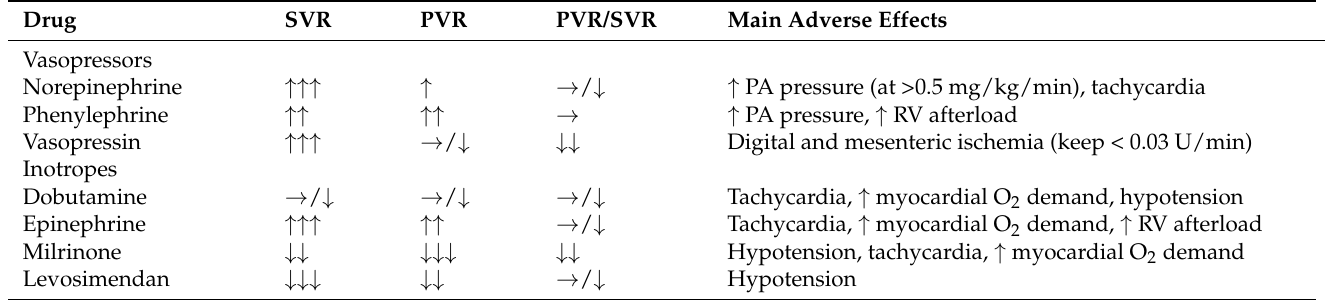
Figure 3. Specific management of RV failure. The figure illustrates the five critical components of the treatment of RV failure, including: ( 1 ) The increase of arterial blood pressure (BP) using vasopressors, including norepinephrine (NE, first line) and vasopressin (second line, when NE doses are >0.5 µ g/kg/min). ( 2 ) The maintenance of sinus rhythm, using anti-arrhythmic drugs or direct current cardioversion in case of atrial fibrillation. ( 3 ) The optimization of RV preload, monitored by echocardiography and central venous pressure. The aim is to ensure adequate RV filling (target a CVP of 8–12 mm Hg) and to aggressively treat volume overload, as evidenced by dilated RV and paradoxical septum movement towards the left ventricle (LV) cavity, using diuretics or renal replacement therapy (RRT). ( 4 ) The reduction of RV afterload (a) by avoiding elevated plateau pressure (P Plat ), driving pressure (DP), and positive end-expiratory pressure (PEEP) in mechanically ventilated patients; (b) by avoiding hypoxemia and hypercapnic acidosis; (c) by prone positioning the patient; (d) by administering inhaled nitric oxide (iNO); (e) by treating thrombo-embolic complications; and (f) in refractory cases, by discussing the possibility of extracorporeal support using veno–venous extracorporeal membrane oxygenation (VV-ECMO). ( 5 ) The increase of RV contractility using inotropic agents, including Dobutamine (first line) and /or Milrinone or Levosimendan (second line). See text for further details. Table 3. Main effects and side effects of vasopressors and inotropes for the treatment of RV